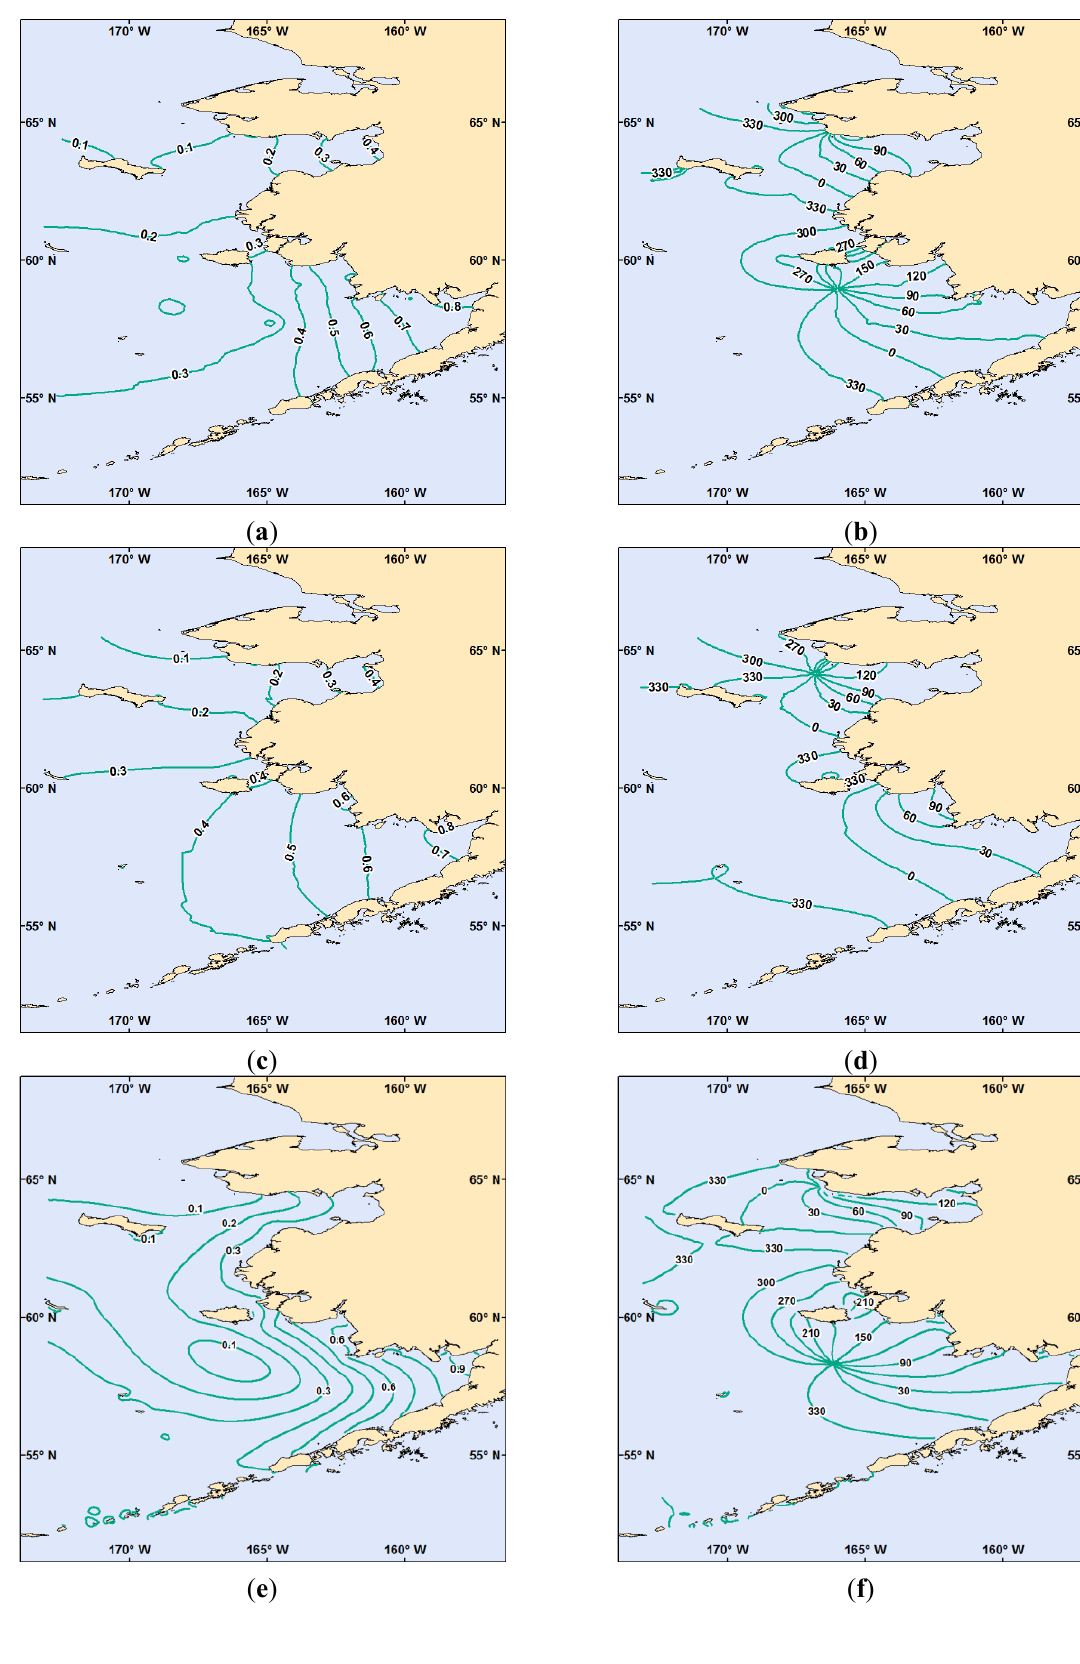
Figure 10. K co-amplitude ( left side panels) and co-phase ( right side panels) contours 1 from TOF ( a , b ); TO ( c , d ); and FM ( e , f